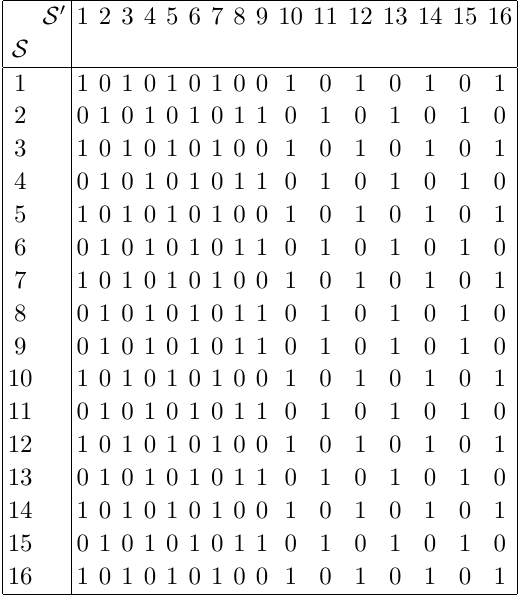
(cid:2) P with di(cid:11)erent boolean factors. [3] [3]